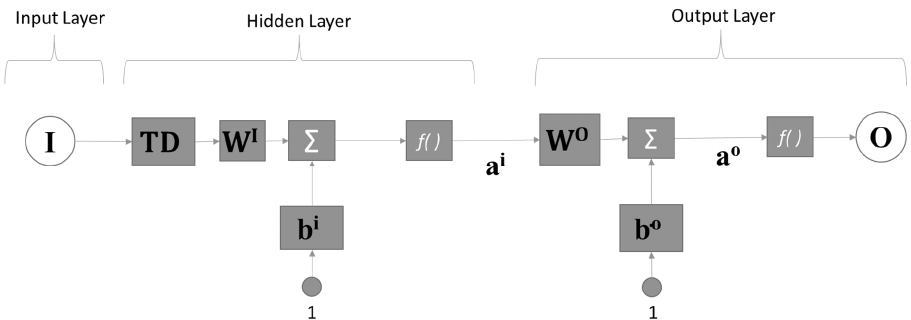
Figure 4. Neural network model example with an input layer, one hidden layer with a time delay, and an output layer.